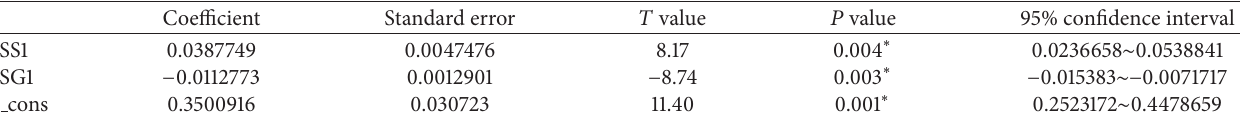
Table 4: The meta-regression results among 6 studies under the additive genetic model for the association of Mink S38G gene polymorphism with AF in the Chinese population.